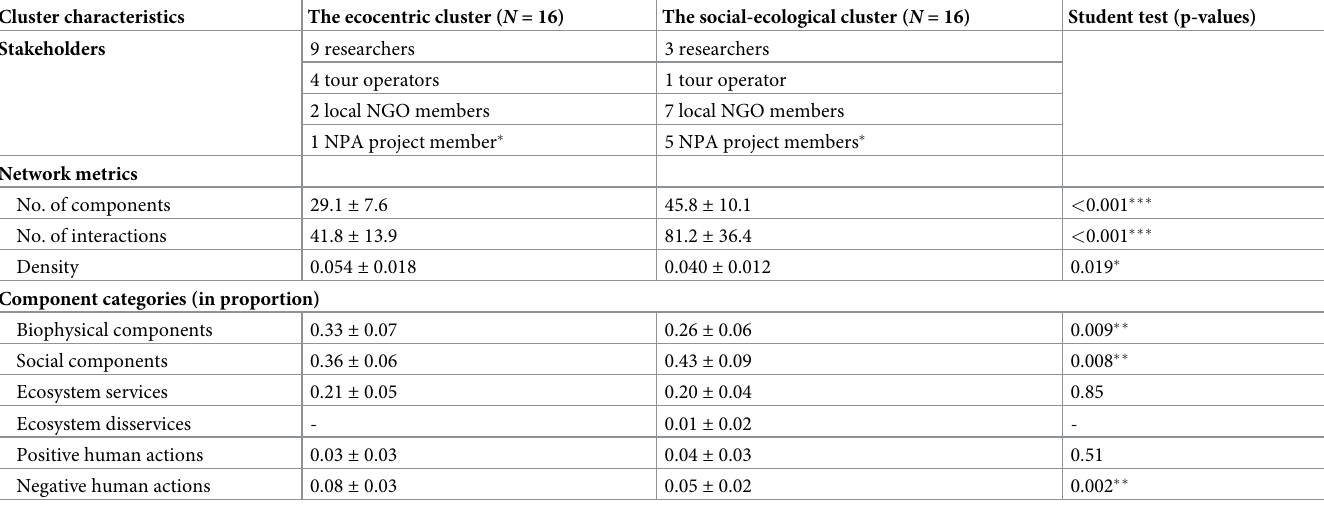
Table 1. Characteristics of the ecocentric vs. social-ecological clusters identified in respondents’ individual cognitive maps (ICMs). Cluster